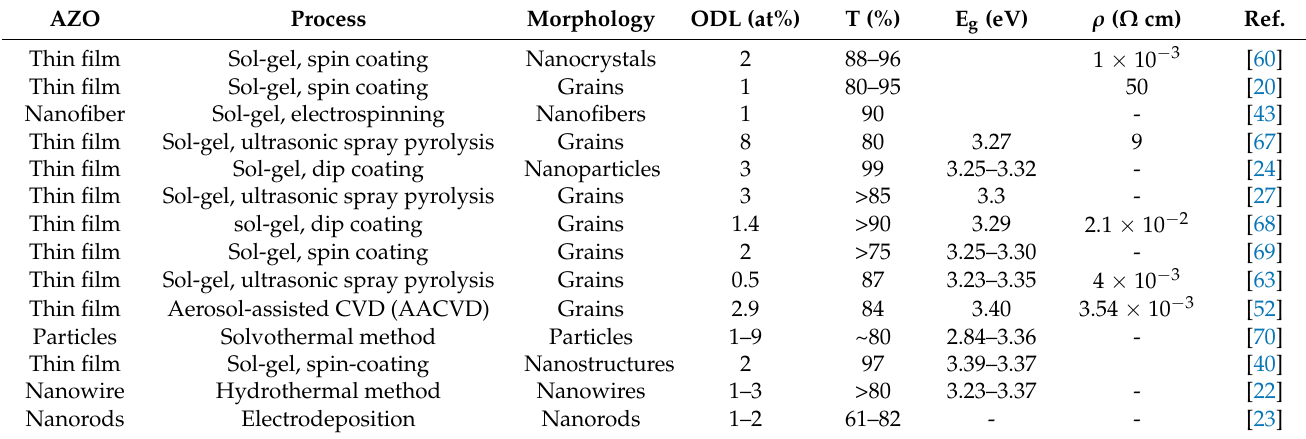
Table 1. Solution processed AZO in different forms, such as granular, nanofibers, nanorods, etc., along with their functional properties. Here, ODL = optimal doping level (at%) of aluminum; T = transmittance (%) of AZO in the visible region; E g = band gap (eV) of AZO; and ρ = resistivity ( Ω cm) of